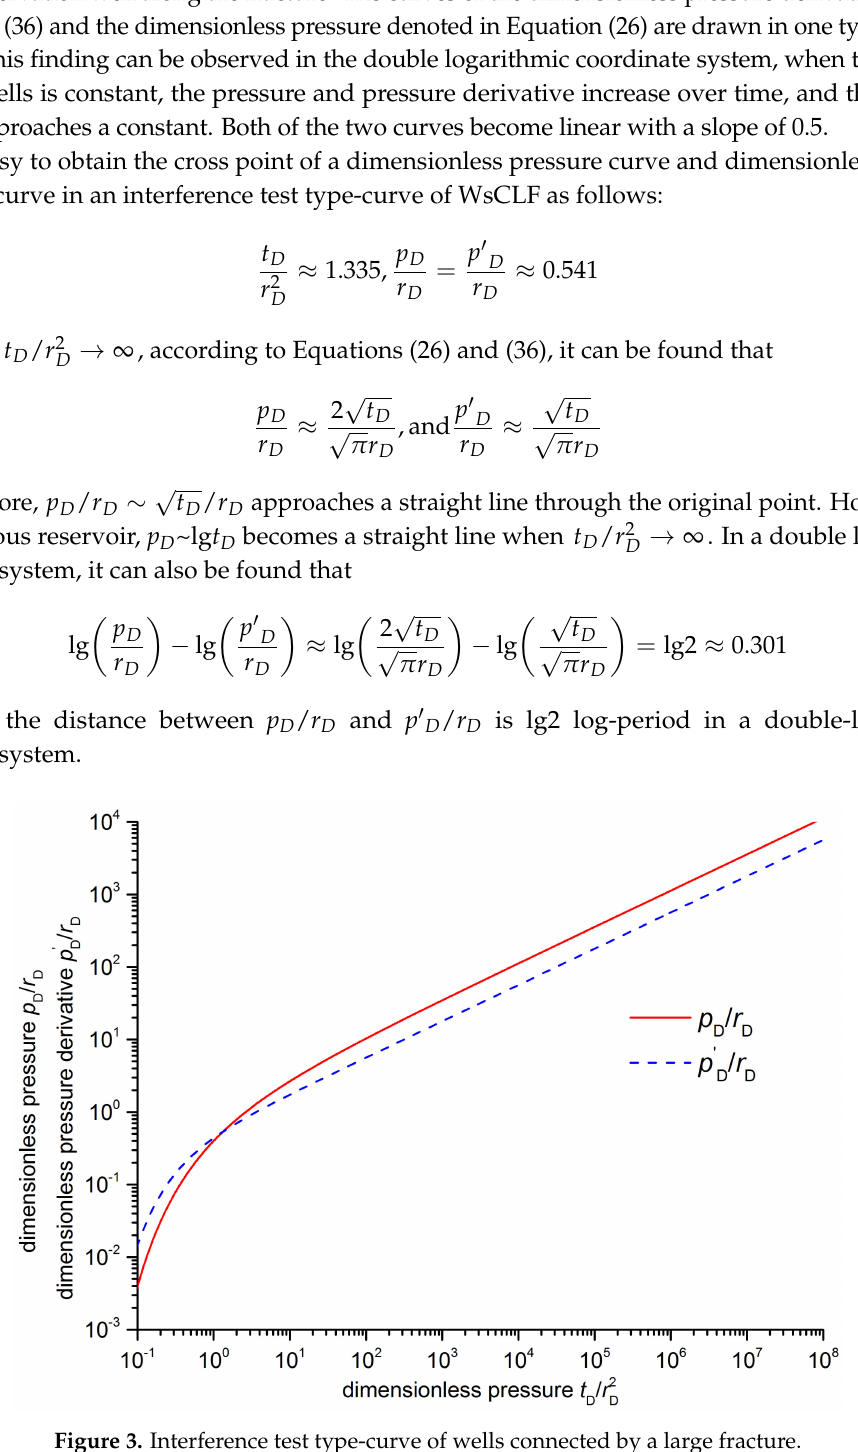
Figure 3. Interference test type-curve of wells connected by a large